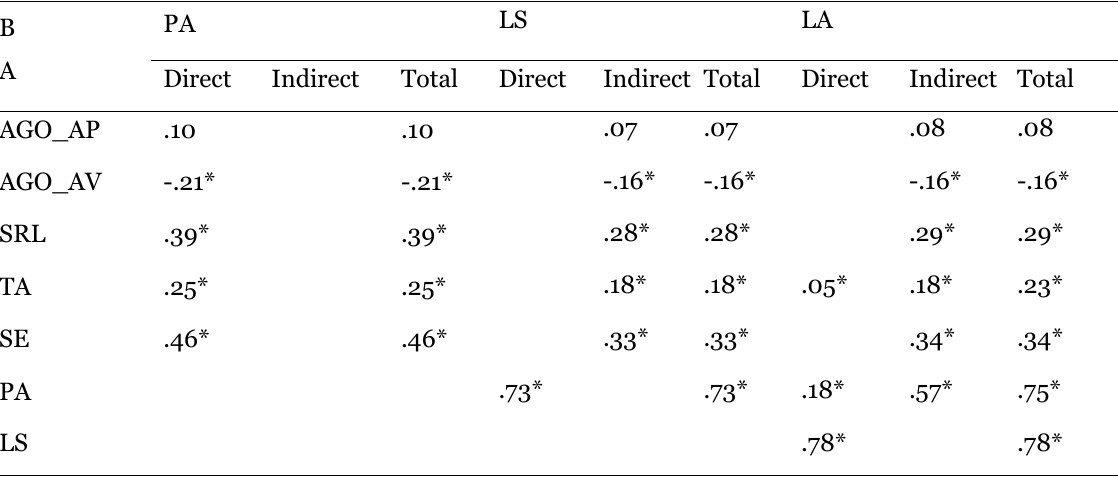
Direct, Indirect, and Total Effects for the Research Model (A ->